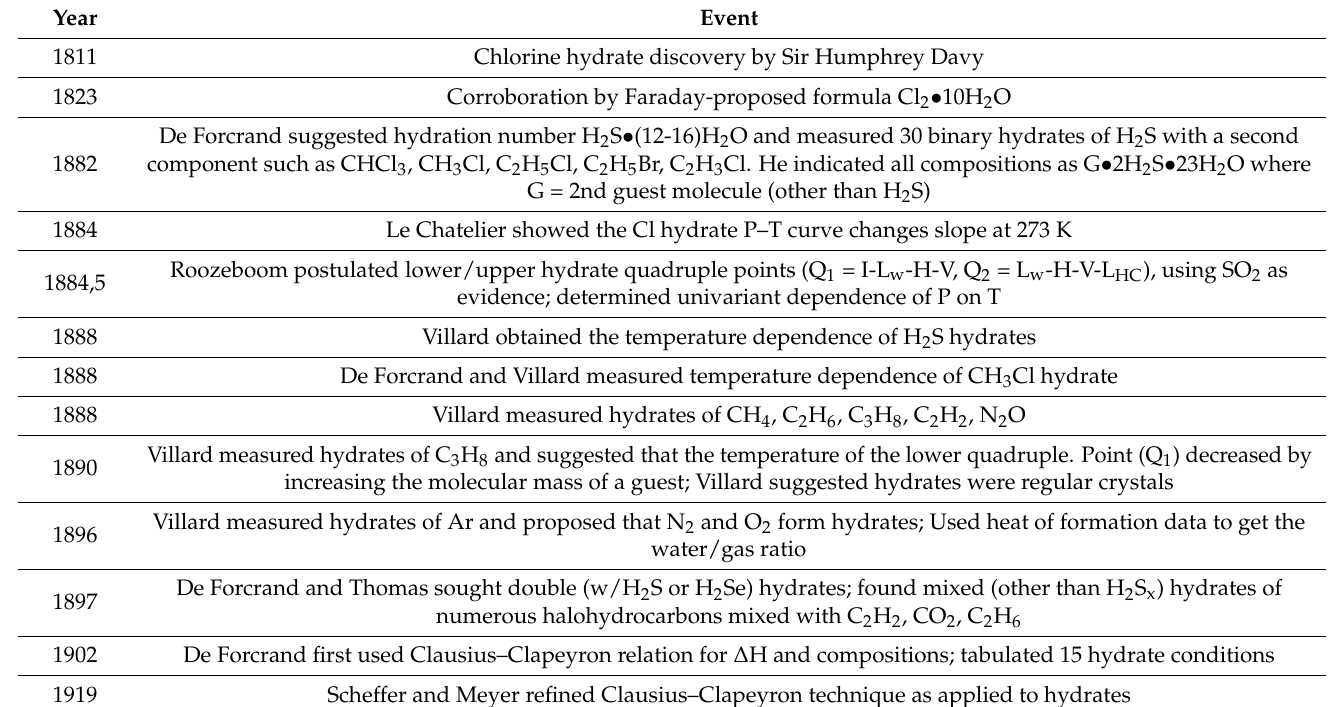
Table 1. Hydrates from 1810 to 1934. Abstracted from pg. 4 of Sloan and Koh [11]. Year Event 1811 Chlorine hydrate discovery by Sir Humphrey Davy